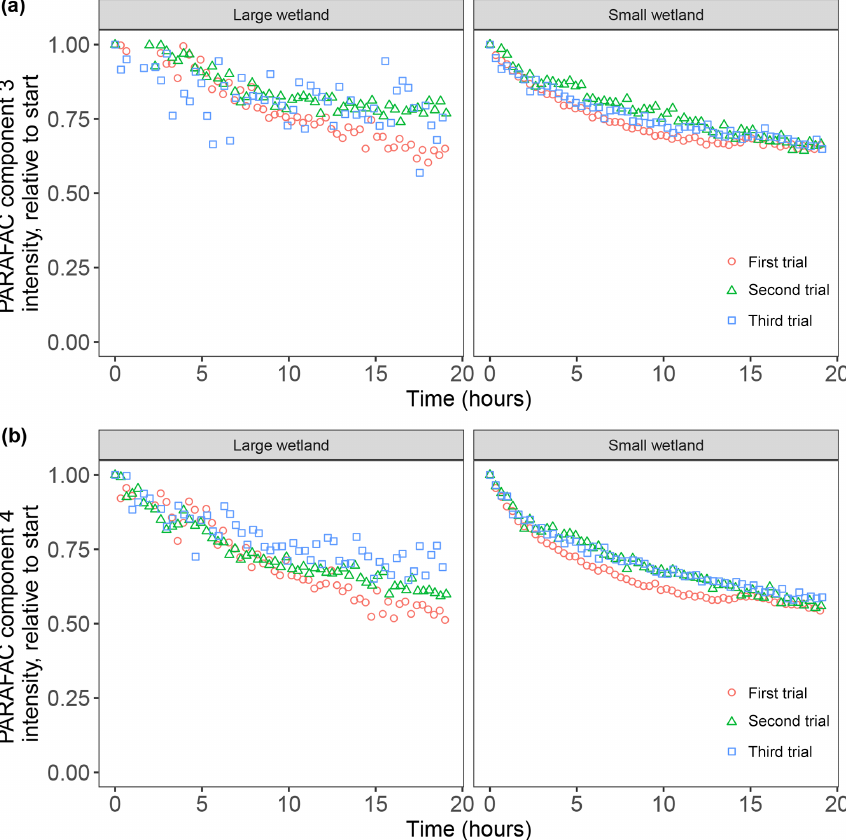
Figure B1. Time series of photodegradation experiments on whole water wetland samples. (a) Change in PARAFAC component three over time, relative to initial intensity. (b) Change in PARAFAC component four over time, relative to initial intensity. Each column represents samples from a different wetland source. A total of three experiments were run, with aliquots drawn from a water sample from each wetland, and results seemed to change with storage time. The first experiments with each wetland water source were run 5–8d after sample collection, the second experiments were run 9–13d after sample collection, and the third experiments were run 14–16d after collection. The trend was, in most cases, toward lower relative photosensitivity in measured variables and, in some cases, increasing data noise (or poor PARAFAC model fit) as sample aged, which informed the decision to use solid phase extracts to improve the reproducibility.